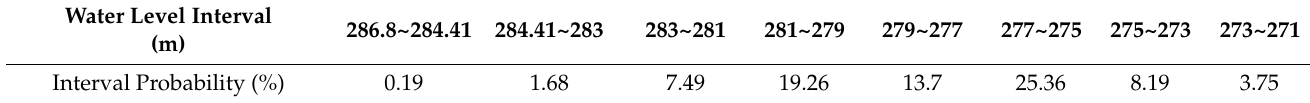
Table 4. Frequency value of the water level classification interval of the Longxingsi